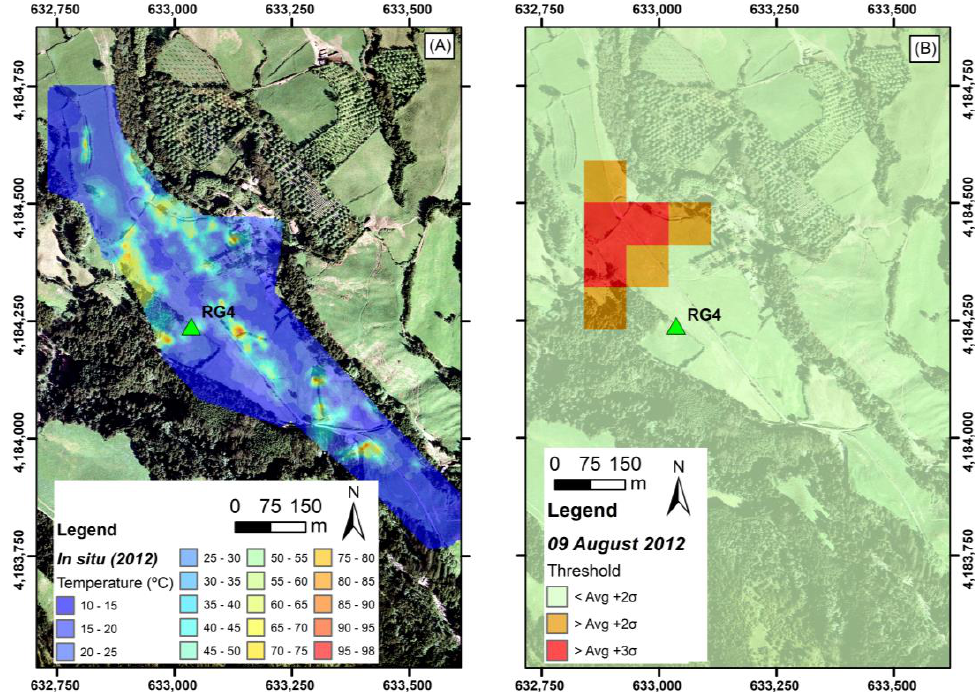
Figure 5. Comparison map with ( A ) in situ soil temperature map (data from January 2012) (Source: F. Viveiros, IVAR/CIVISA, 2012) and ( B ) thermal anomalies on 08 August 2012.